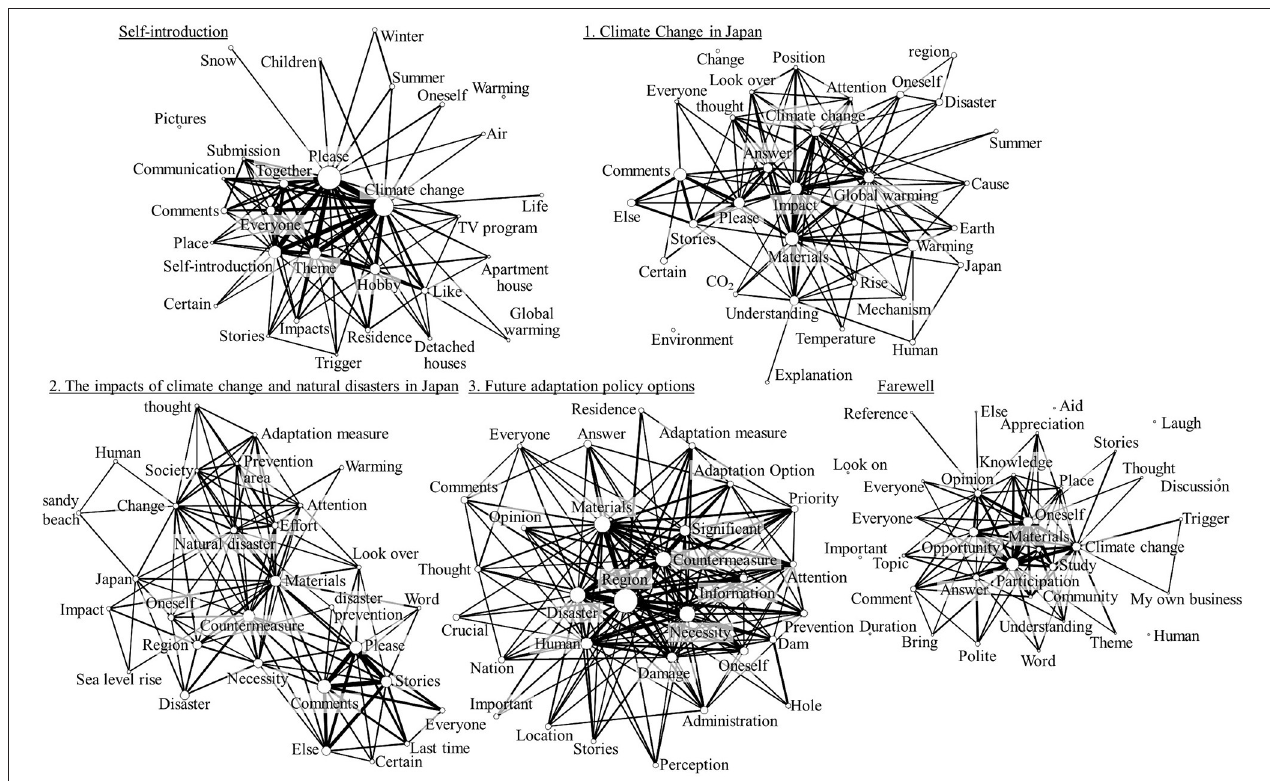
FIGURE 2 | Network Graph of the top word of the number of occurrences in each topic.